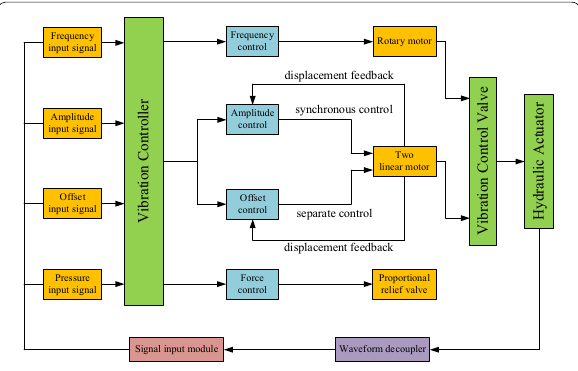
Figure 26 Principle block diagram of control